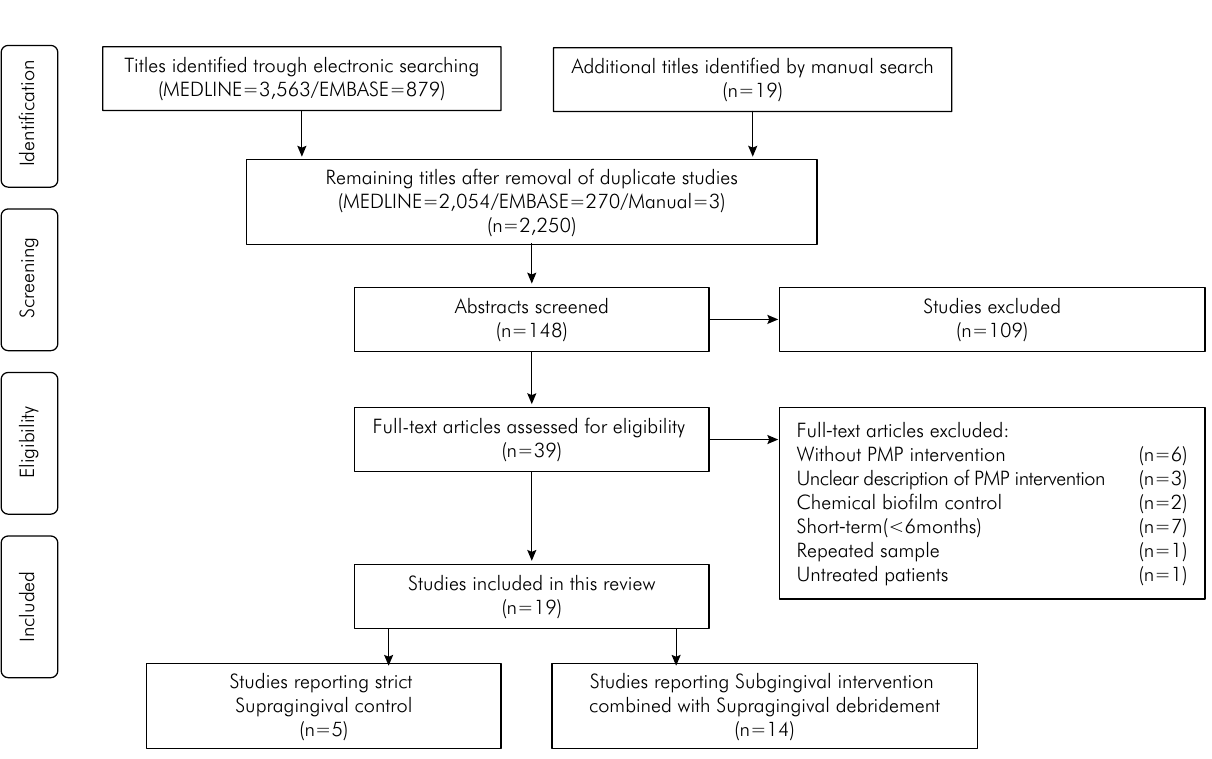
Figure 1. Flowchart of the studies